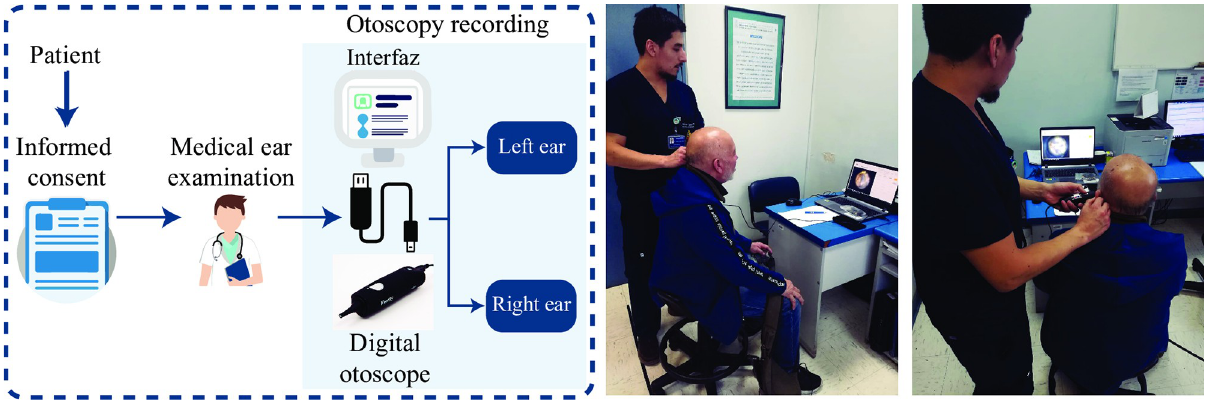
Fig 2. General procedure to obtain video otoscopies: The patient after signing the informed consent goes to one of boxes of the Clinical Hospital from Universidad de Chile . The physician performs the examination using a digital otoscope and the records are saved in a computer. The right and left ear examination using the system developed is